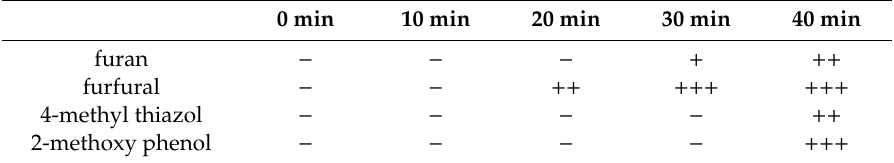
Table 3. Aroma intensity of some aroma volatile compounds. 0 min 10 min 20 min 30 min 40 min furan − − − + ++ furfural − − ++ +++ +++ 4-methyl thiazol − − − − ++ 2-methoxy phenol −